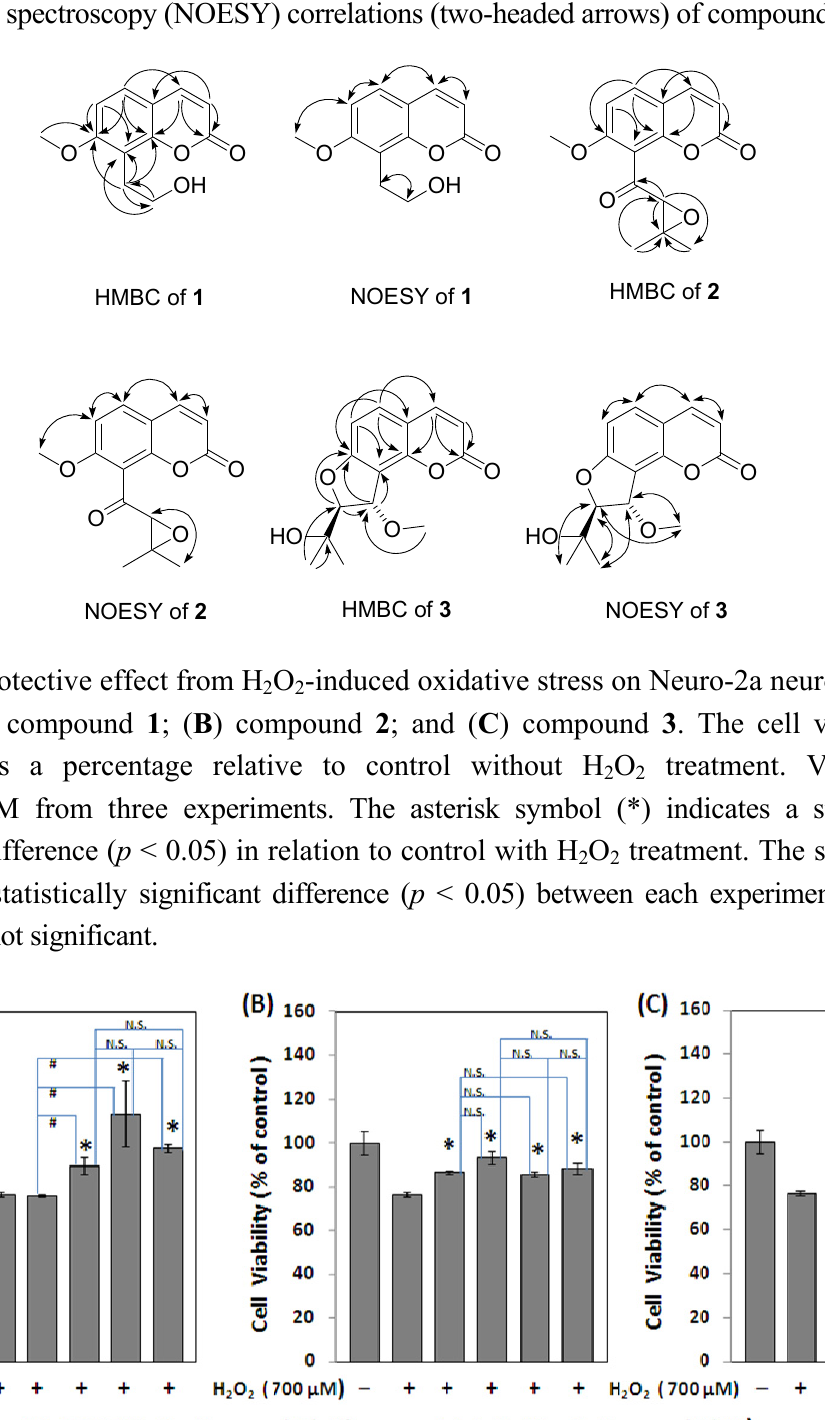
Figure 2. Significant heteronuclear multiple bond coherence (HMBC) and nuclear Overhauser enhancement spectroscopy (NOESY) correlations (two-headed arrows) of compounds 1 – 3 .